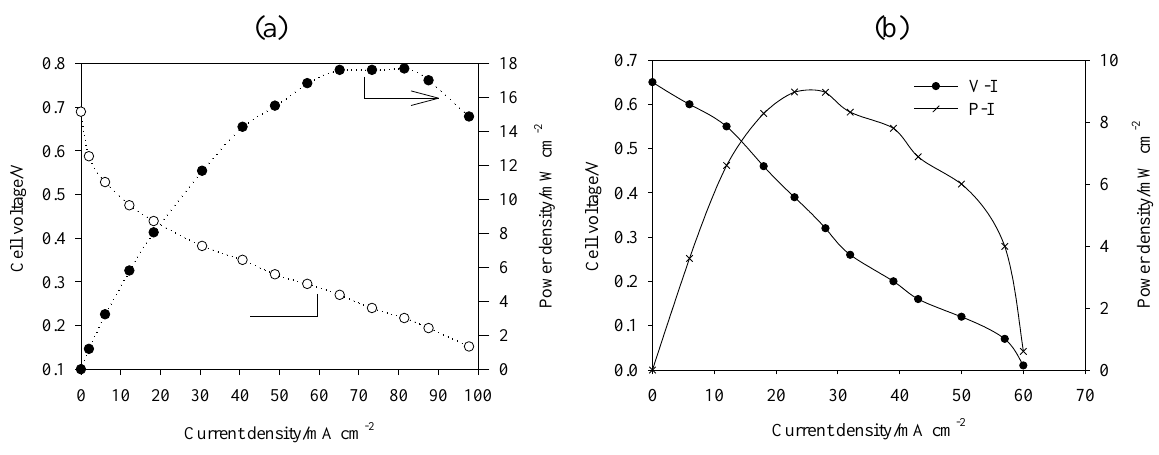
Figure 4. Fuel cell polarisation curves and power density curves for the DMAFC using air at 60 °C, air pressure 1 bar: (a) 1 M methanol with 1 M NaOH [21]; (b) 1 M methanol